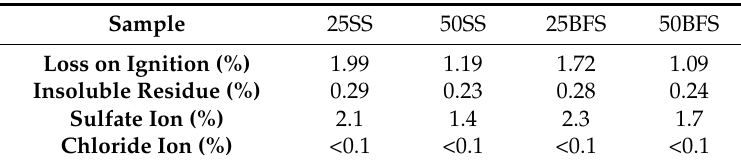
Table 7. Chemical